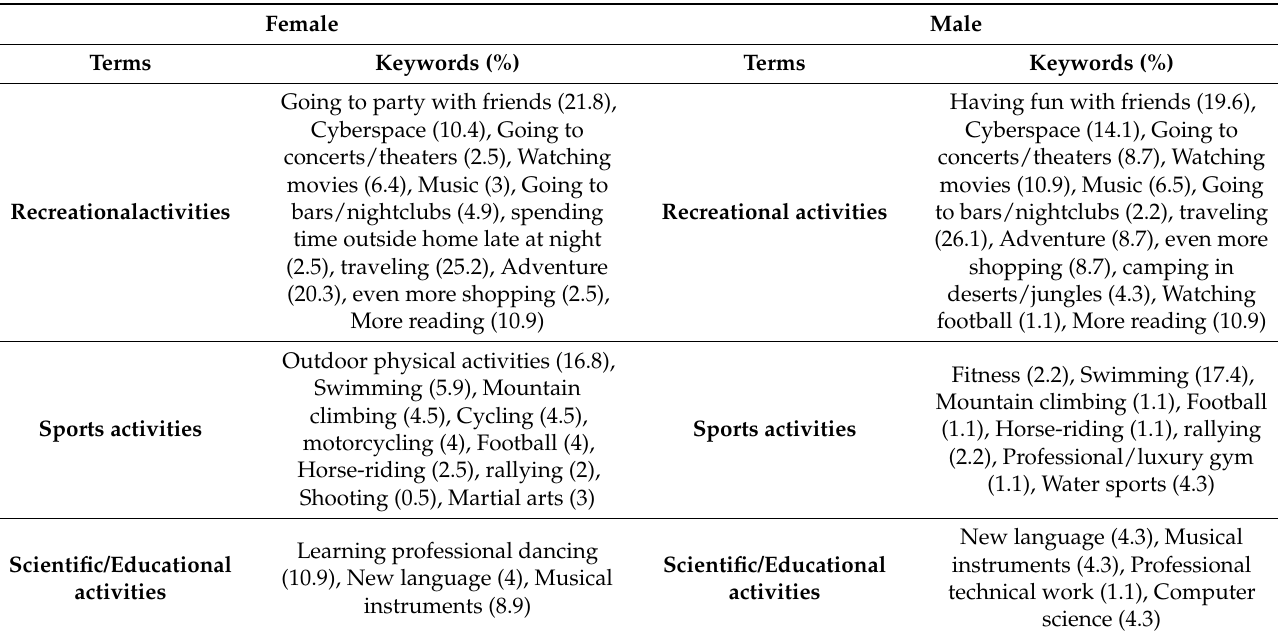
Table 6. Desired free time activities from participants’ viewpoint.